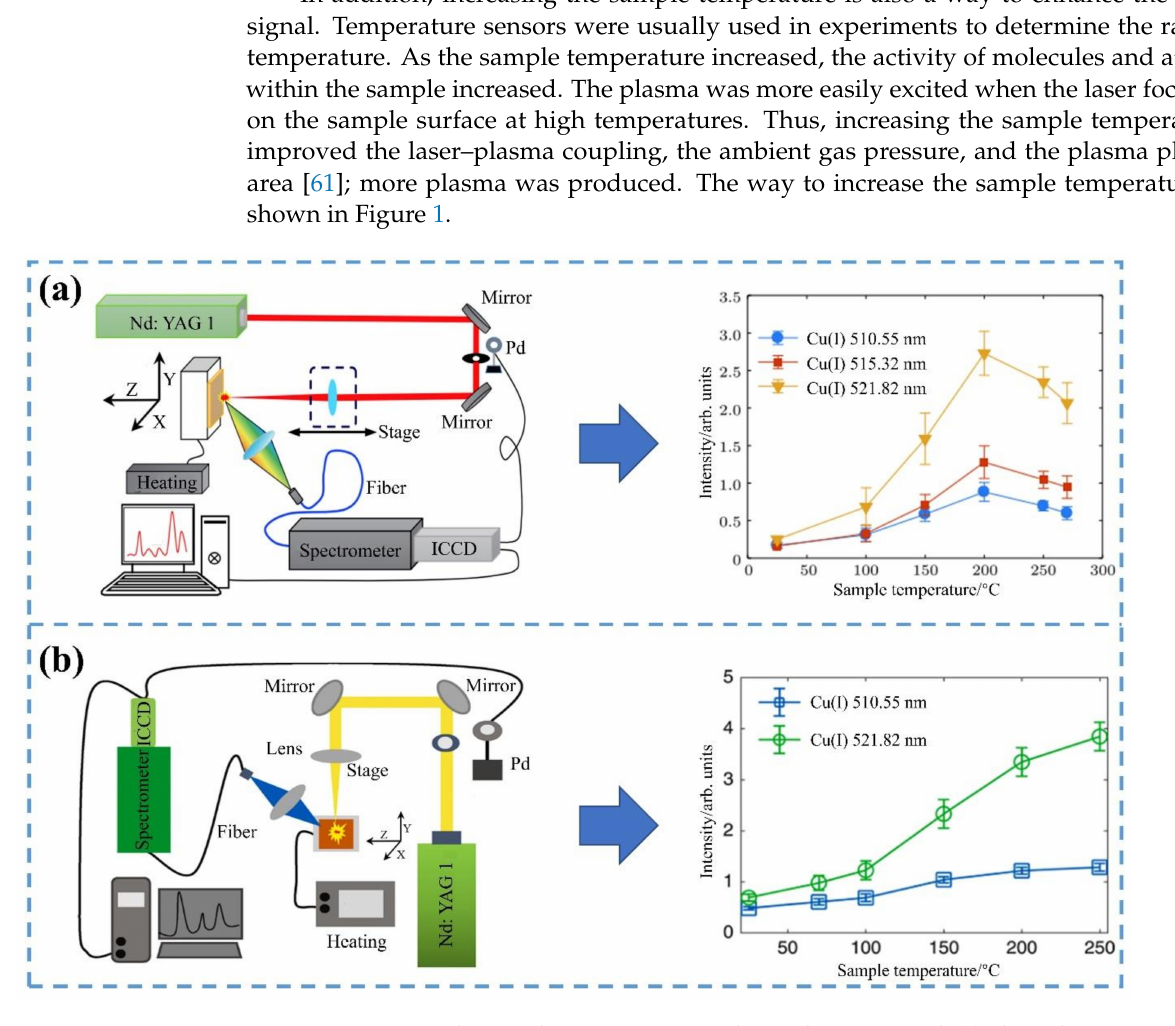
Figure 1. Increasing the sample temperature to enhance the LIBS signal. ( a ) Three characteristic lines of Cu element; ( b ) two characteristic lines of Cu